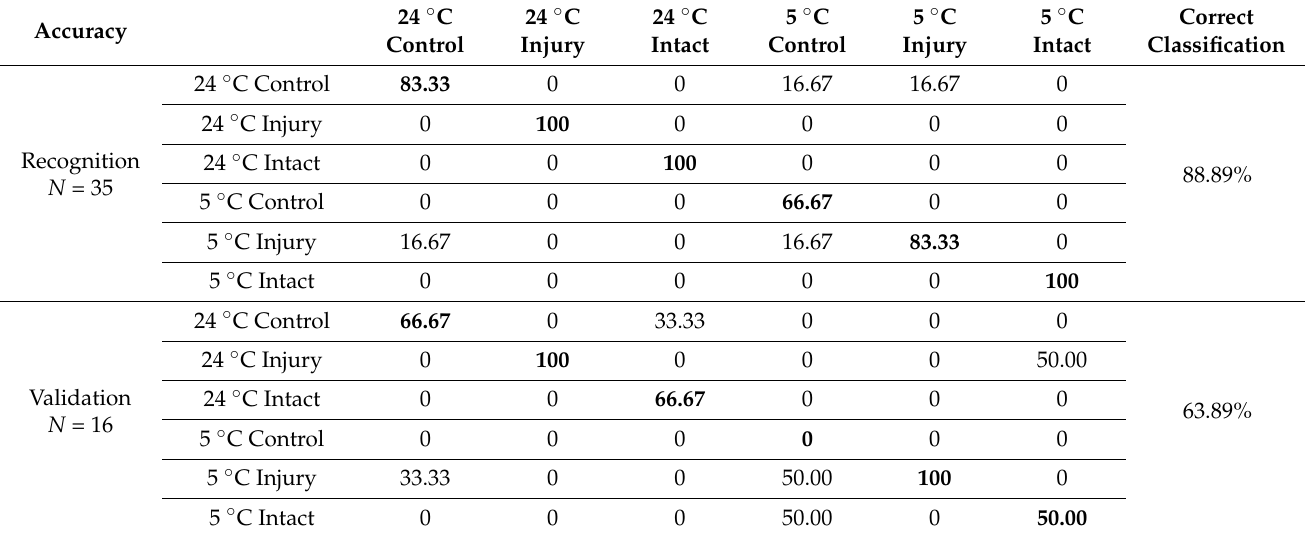
Table 6. LDA classification model on the e-tongue data of control and infected raw plum juices with second parallel sample validation when the different treatment groups were used as class variable ( N = 51).